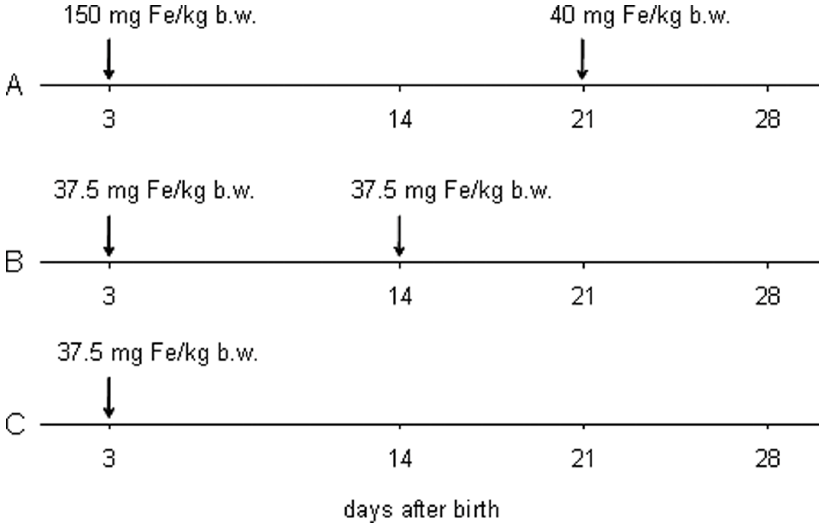
Figure 1. Experimental design scheme. 3 various protocols of iron dextran administration in piglets are indicated as A, B and C. Iron dextran was injected to piglets on days indicated by arrows. Blood samples were collected on days 3, 14, 21 and 28 after birth. When iron dextran injection and blood collection fell on the same day, blood was always drawn before iron administration.